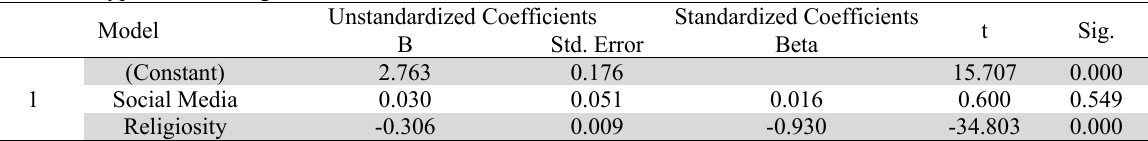
Results of Hypothesis Testing